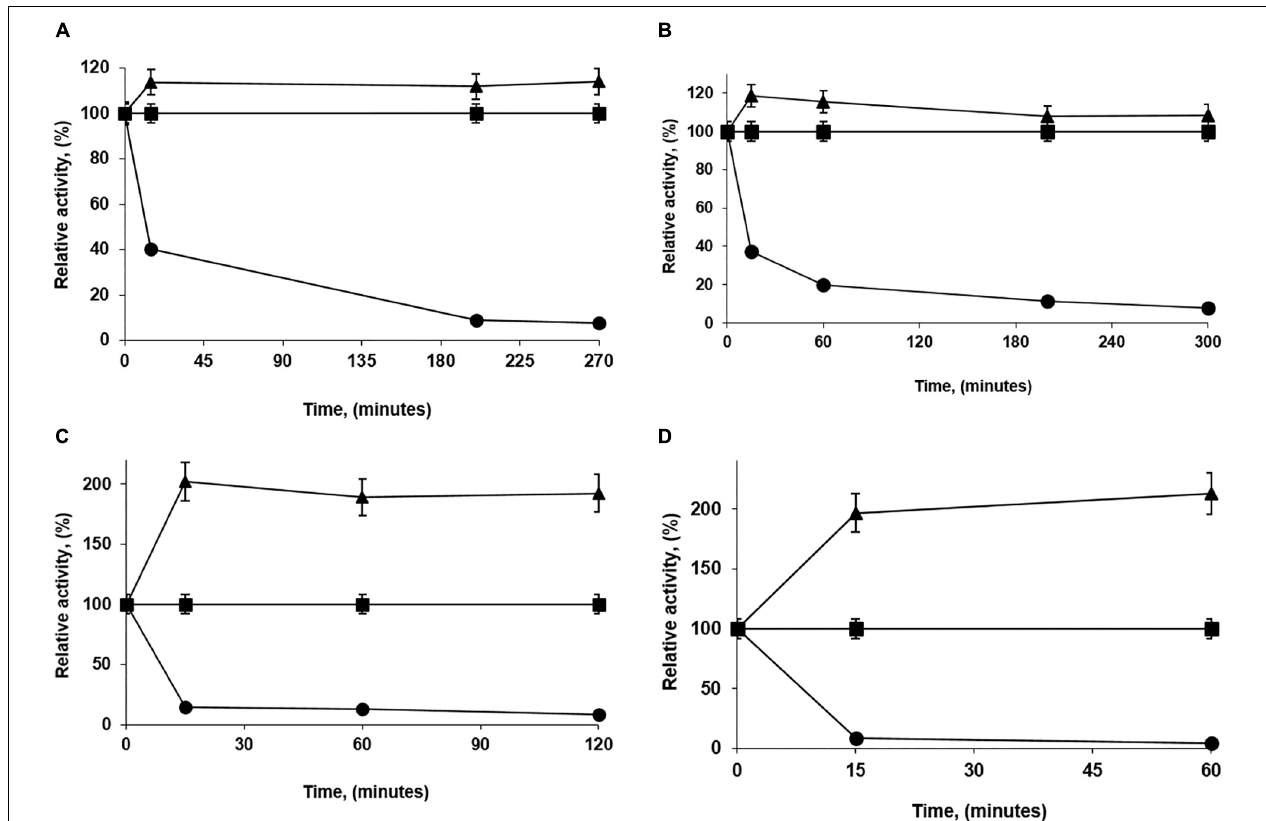
FIGURE 1 | Immobilization courses of low loaded PFL preparations (1 mg/g). Immobilization conditions: (A) 5 mM of sodium acetate buffer with 30% glycerol at pH 5.0; (B) 5 mM of Tris buffer with 30% glycerol at pH 7.0; (C) 250 mM of sodium phosphate buffer at pH 7.0 and (D) 5 mM of sodium bicarbonate buffer with 250 mM NaCl at pH 9.0. Other specifications are described in section “Methods.” Solid squares: reference; solid triangles: suspension and solid circles: